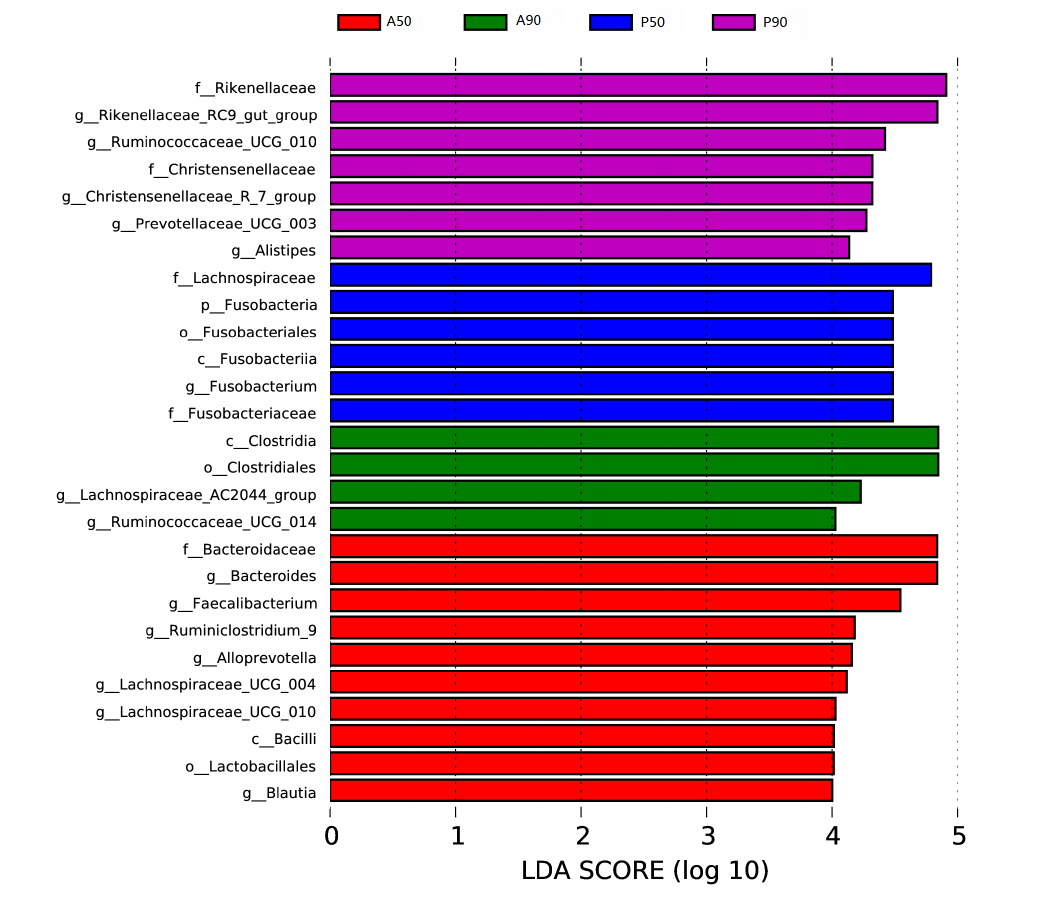
Figure 3. Association of specific microbiota taxa of the microbiota in the feces of calves fed pasteurized milk (PM) and acidified milk (AM) ad libitum by linear discriminant analysis (LDA) effect size (LEfSe). Significant differences are defined as p<0.05 and LDA score >4.0. A50, feces samples of calves fed AM on day 50; A90, feces samples of calves fed AM on day 90; P50, feces samples of calves fed PM on day 50; P90, feces samples of calves fed PM on day